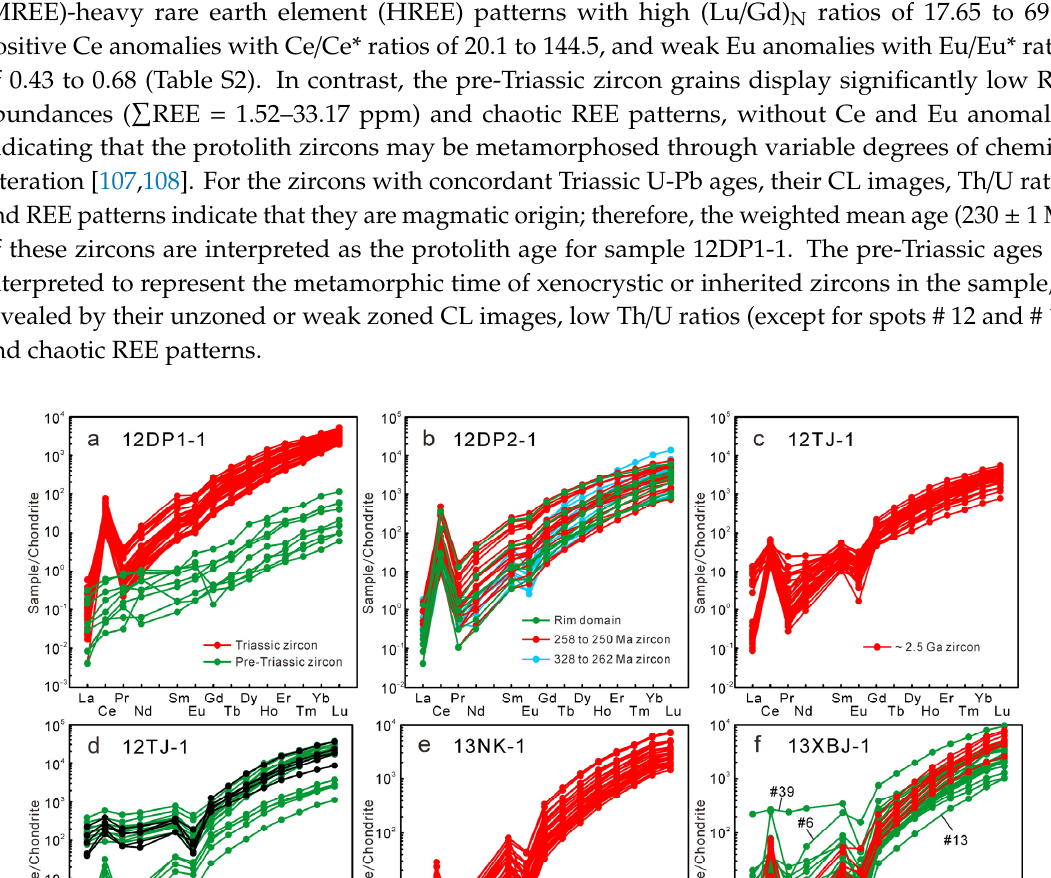
Based on the chondrite normalized REE patterns (Figure 8b), the pre ‐ Triassic zircons from